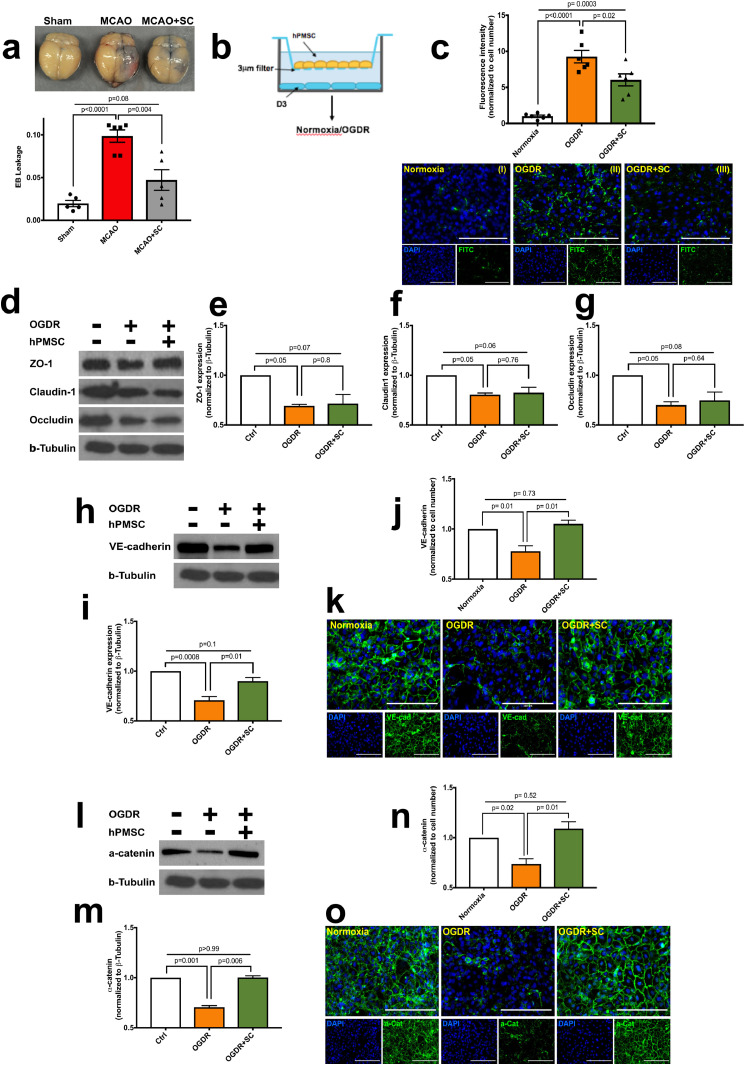
hPMSCs maintain blood brain barrier integrity against MCAO in mice.(a) BBB disruption assessed by Evans blue (EB) leakage into the brains of sham (n = 4), MCAO (n = 6), hPMSC-treated MCAO (n = 5) mice 24 h following reperfusion. Significant differences in EB leakage were observed between MCAO versus sham (⁎⁎⁎⁎p = 0.0001, one-way ANOVA) and hPMSC-treated MCAO mice (⁎⁎⁎p = 0.004, Student's t-test). No significant differences were detected between hPMSC-treated MCAO versus sham (NS, p = 0.08, one-way ANOVA).(b) Schematic of in vitro model of ischemic stress.(c) Barrier function of human brain endothelial (hCMEC-D3) monolayers under normoxia and oxygen-glucose deprivation reperfusion (OGDR) condition were measured using biotinylated-gelatin/FITC-avidin evaluation. Significant differences in fluorescence intensity of D3 monolayers were observed under normoxia versus OGDR (⁎⁎⁎⁎p<0.0001, One-way ANOVA) and OGDR versus OGDR+hPMSC (*p = 0.02, Student's t-test). (I to III) Representative images of biotinylated-gelatin FITC-avidin permeability assay of monolayers under (I) normoxic, (II) OGDR, and (III) OGDR+hPMSC conditions. Scale bars, 100 μm (I to III).(d) Western blots for expression of ZO-1, Claudin-1, Occludin, and β-tubulin in D3 monolayers under normoxia and OGDR (with/without hPMSC).Quantification of ZO-1 (e), claudin1 (f), and occludin (g) expression normalized to β-tubulin protein expression. No significant differences were observed in the expression of ZO-1 (e; p = 0.8), claudin1 (f; p = 0.76) or occludin (g; p = 0.64) in monolayers under OGDR condition versus OGDR+hPMSC group using two-tailed Student's t-test analysis.Immunoblot and quantification of VE-cadherin (h, i) and α-catenin (l, m) protein expression normalized to β-tubulin. Significant differences were found between OGDR versus OGDR+hPMSC (i;⁎⁎p = 0.01 and m;⁎⁎⁎p = 0.006, Student's t-test). Immunofluorescence staining and quantification of VE-cadherin (j, k) and α-catenin (n, o). Fluorescence intensity of VE-cadherin and α-catenin (green color; k and o, respectively) was normalized to cell numbers (DAPI-stained nuclei, blue color). Significant differences in fluorescent intensity for VE-cadherin (j; ⁎⁎p = 0.01, Student's t-test) and α-catenin (n; ⁎⁎p = 0.01, Student's t-test) were observed in hPMSC-treated monolayers under OGDR. Scale bars, 100 μm (k and o). (For interpretation of the references to color in this figure legend, the reader is referred to the web version of this article.)